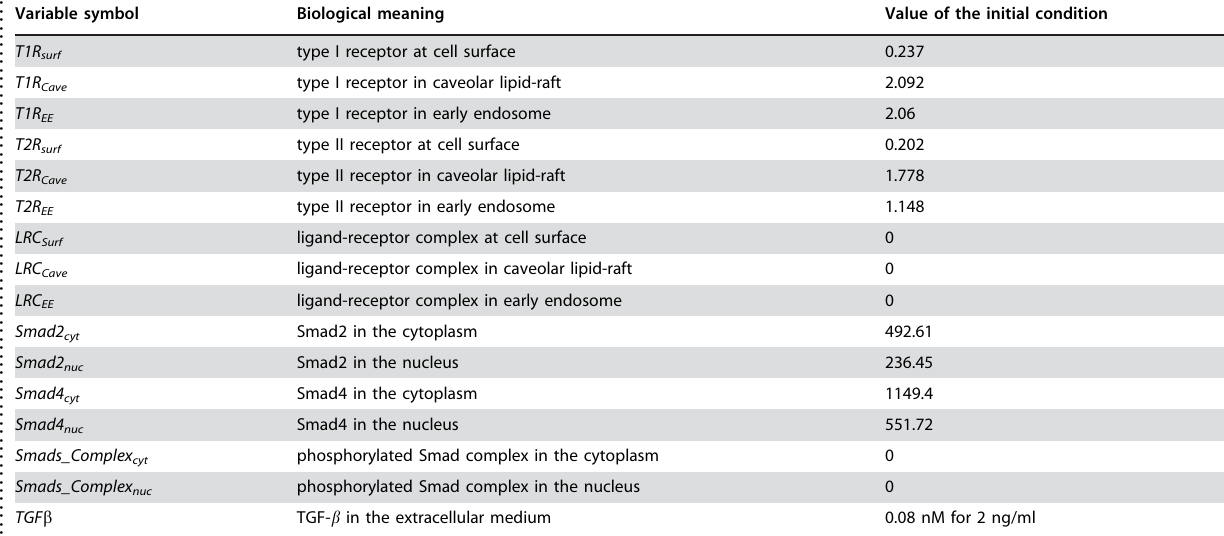
Table 2. Initial conditions of state variables (proteins) in the model .. ... .... ... ... .... ... ... .... ... ... .... ... ... .... ... ... .... ... ... .... ... ... .... ... ... .... ... ... .... ... ... .... ... ... .... ... ... .... ... ... .... ... ... . Variable